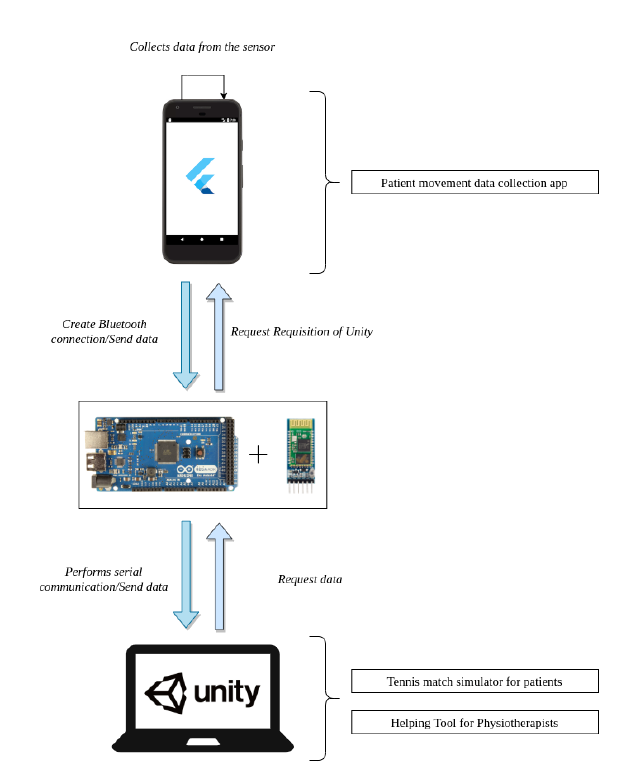
Figure 1. Solution architecture. Source: Author